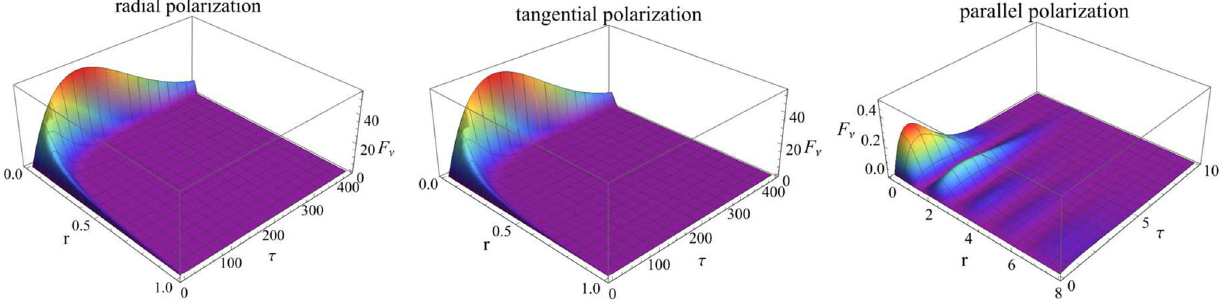
Fig. 4 QFI of the deficit angle parameter ν as a function of the effec- tive time τ and the effective distance r . The left to right panels cor- respond to the radial polarization (ζ r ,ζ α ,ζ z ) = ( 1 , 0 , 0 ) , the tangen- tial polarization (ζ r ,ζ α ,ζ z ) = ( 0 , 1 , 0 ) and the parallel polarization (ζ ,ζ α ,ζ ) = ( 0 , 0 , 1 ) , respectively. We take the deficit angle param- r z